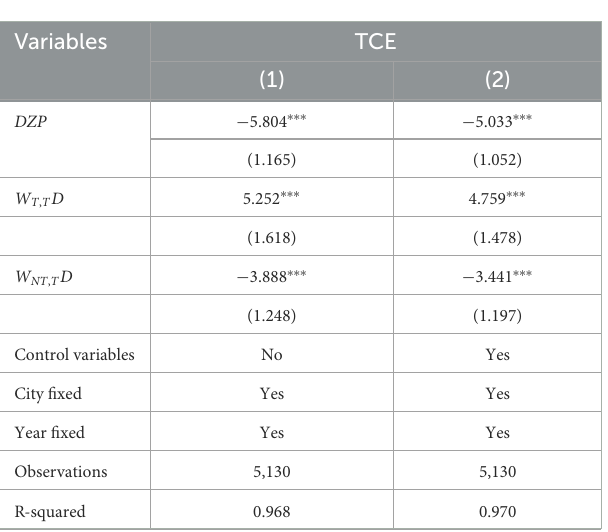
TABLE 9 Policy upgrade and superposition test